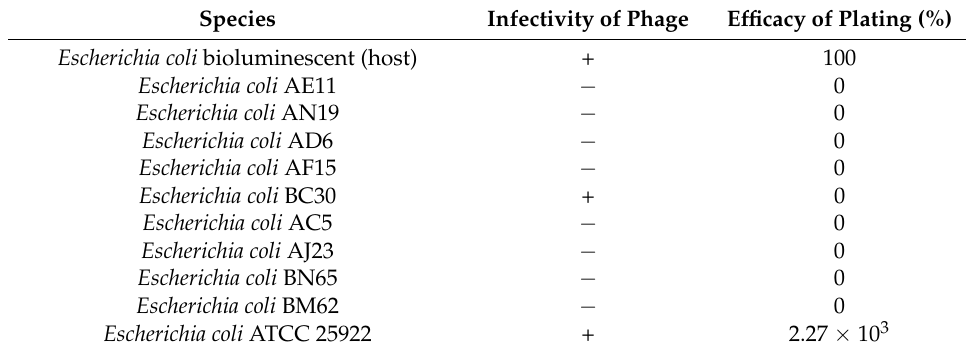
Table 1. Host range and efficiency of plating of phage ELY-1 determined on 32 bacterial strains. Clear lysis zone (+) and not lysis zone ( −